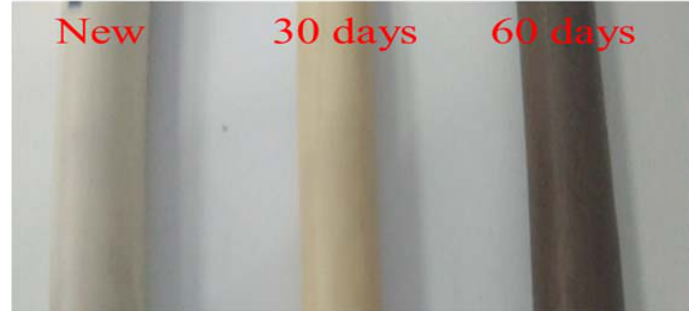
Figure 1. Digital photographs of polyvinyl chloride (PVC) sheaths before and after thermal aging.